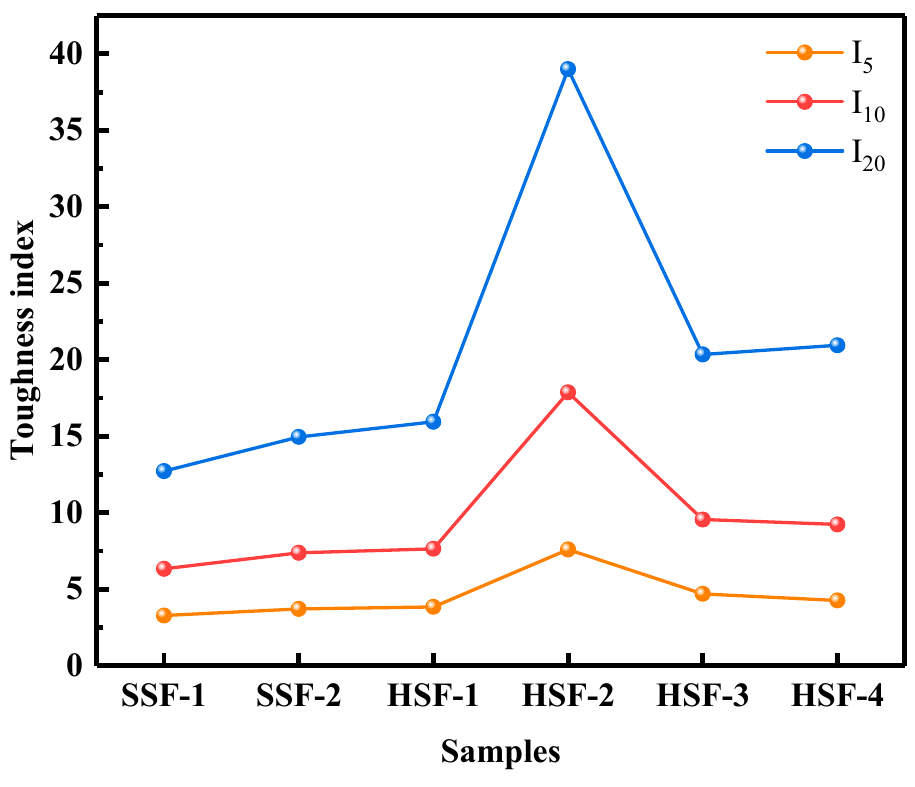
Figure 8. Toughness index of FRC.